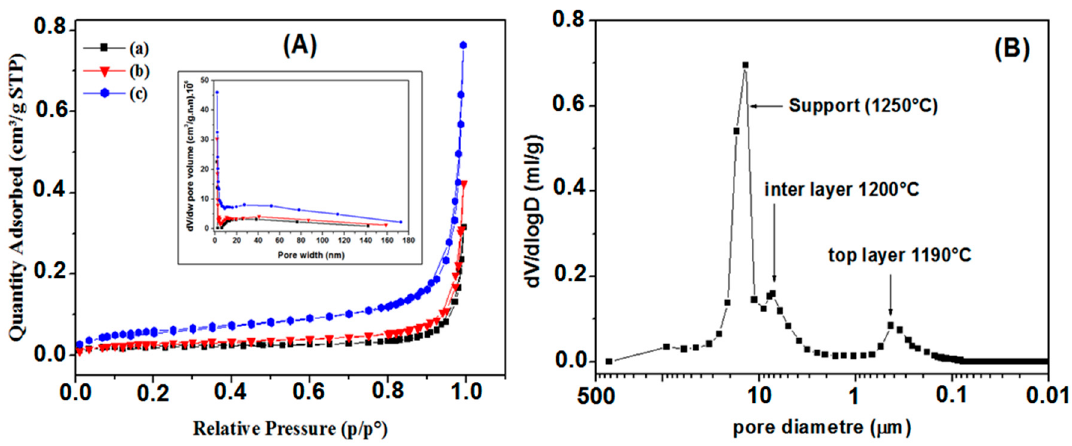
15 of 20 Figure 12. SEM micrographs; ( a ) surface of intermediate layer, ( b ) surface of a top layer ( c ), cross- section of the multilayer system. Figure 13 presents the analysis results obtained through the two methods used to characterize the textural features of the membranes. Figure 13A shows the nitrogen ad- sorption/desorption isotherms, acquired at 77K, of the studied samples. All the samples show Type II isotherms with a Type H3 hysteresis loop, similar to those of powders and aggregates. According to the IUPAC classification [51], these samples are classified as mesoporous materials. The adsorption behavior in mesopores is determined by the ad- sorbent–adsorptive and adsorptive–adsorptive interactions. This leads to the occurrence of multilayer adsorption and capillary condensation, which are accompanied by a hyste- resis curve whose shape is related to the texture of the adsorbent. H3 hysteresis is the result of inter-particle capillary condensation. From the nitrogen adsorption isotherms, it is evident that sample (c) has a relatively compact structure. Indeed, the specific surface area (SSA) increases with the number of layers. The resulting SSA measurements are 0.087, 0.113 and 0.222 m 2 g − 1 , corresponding to the samples (support), (support + inter- layer), and (support + interlayer + top layer), respectively. The same behavior is observed for the total pore volume (V T ). The smallest value, V T = 47 × 10 − 5 cm 3 ·g − 1 , corresponds to sample (a), the median value, V T = 65 × 10 − 5 cm 3 ·g − 1 , corresponds to sample (b), while the maximum value, 117 × 10 − 5 cm 3 ·g − 1 , was obtained for sample (c). Figure 13B presents the